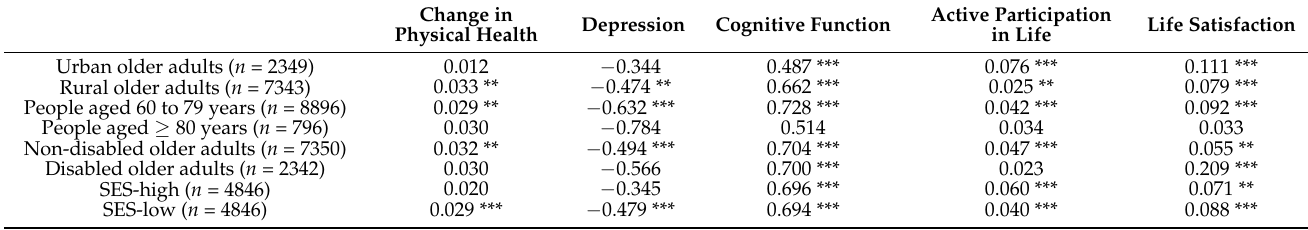
Table 5. Heterogeneity analysis (nuclear